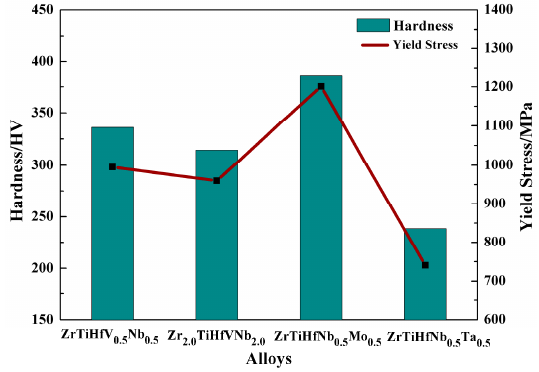
Figure 4. The hardness and compression yield stress of these RHEAs.